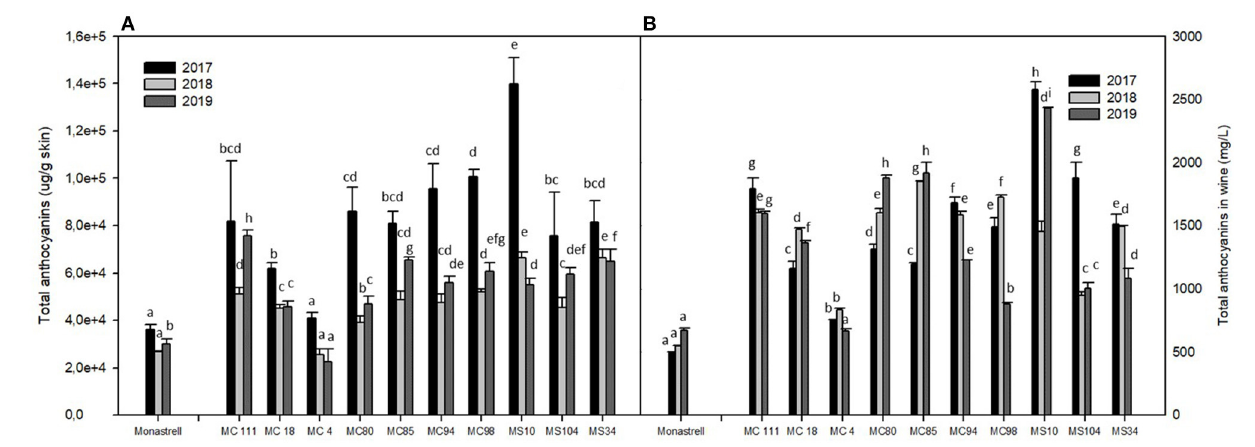
FIGURE 1 | Total anthocyanins in grapes (A) and wines (B) in the three seasons (2017–2019).